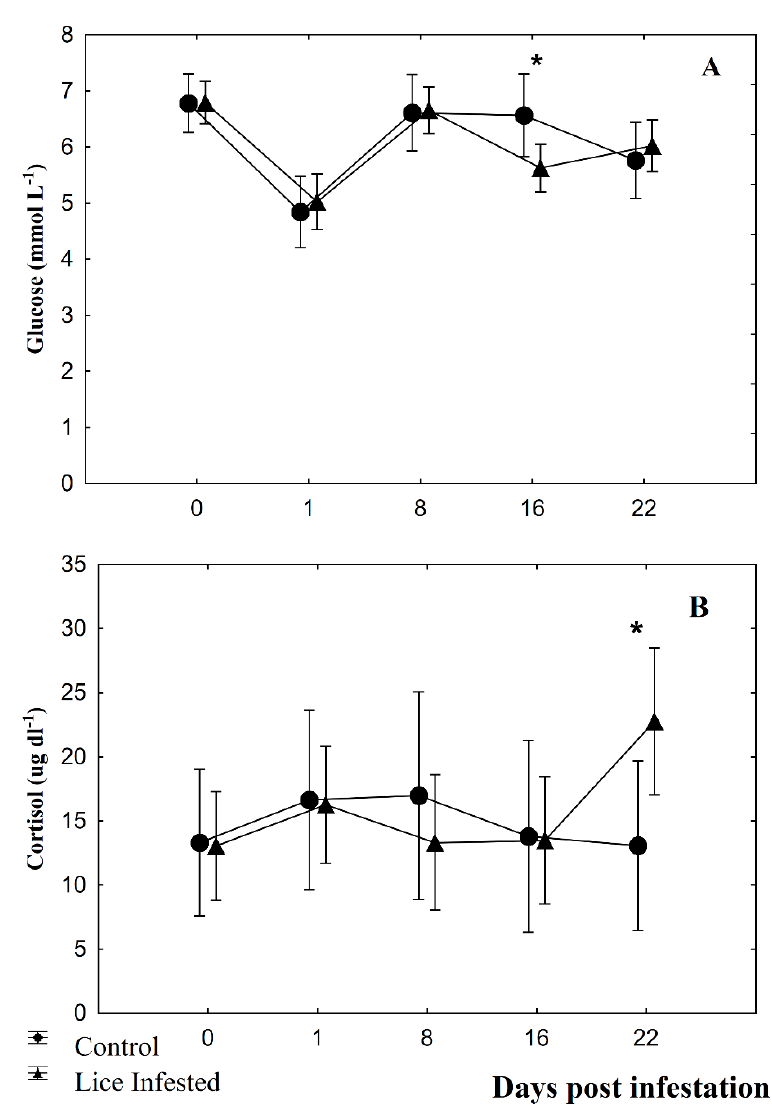
Figure 2. Physiological plasmatic parameters of control and Caligus rogercresseyi infested groups of Atlantic salmon ( Salmo salar ), corresponding to ( A ) glucose, and ( B ) cortisol levels during the time curse (days post infestation). Mean ± 0.95 Confidence Interval. Asterisks show significant differences ( p < 0.05) compared to the fish in the control group on that day.